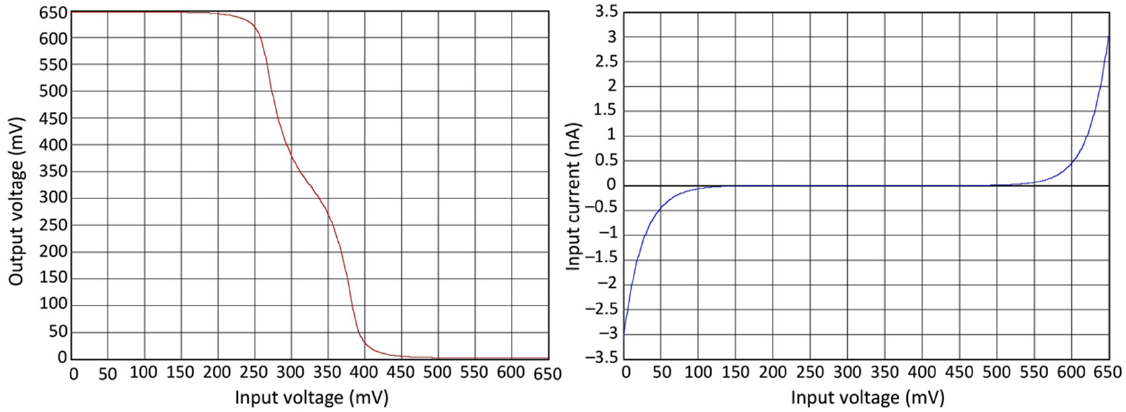
Figure 5. Transfer characteristic and input current of a CBip inverter. V CC = 0.65 V, temperature 300 K.